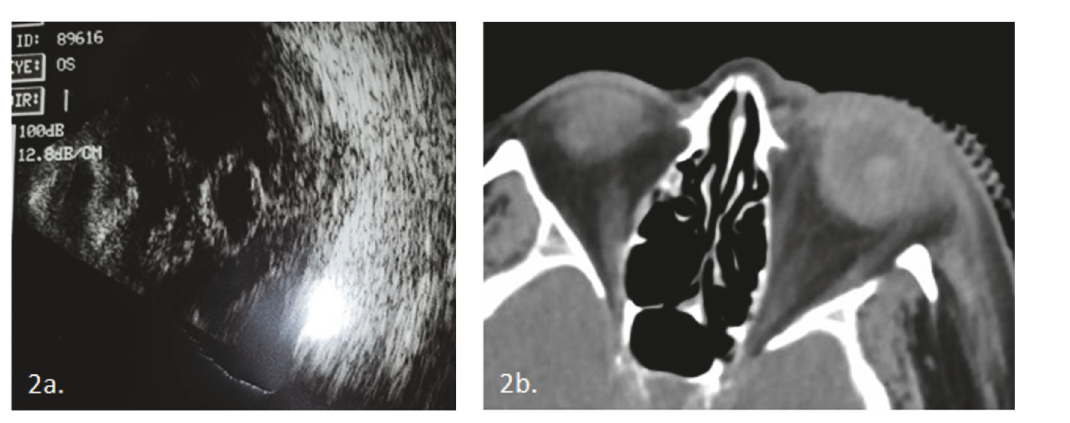
Figure 1: Panophthalmitis of the left